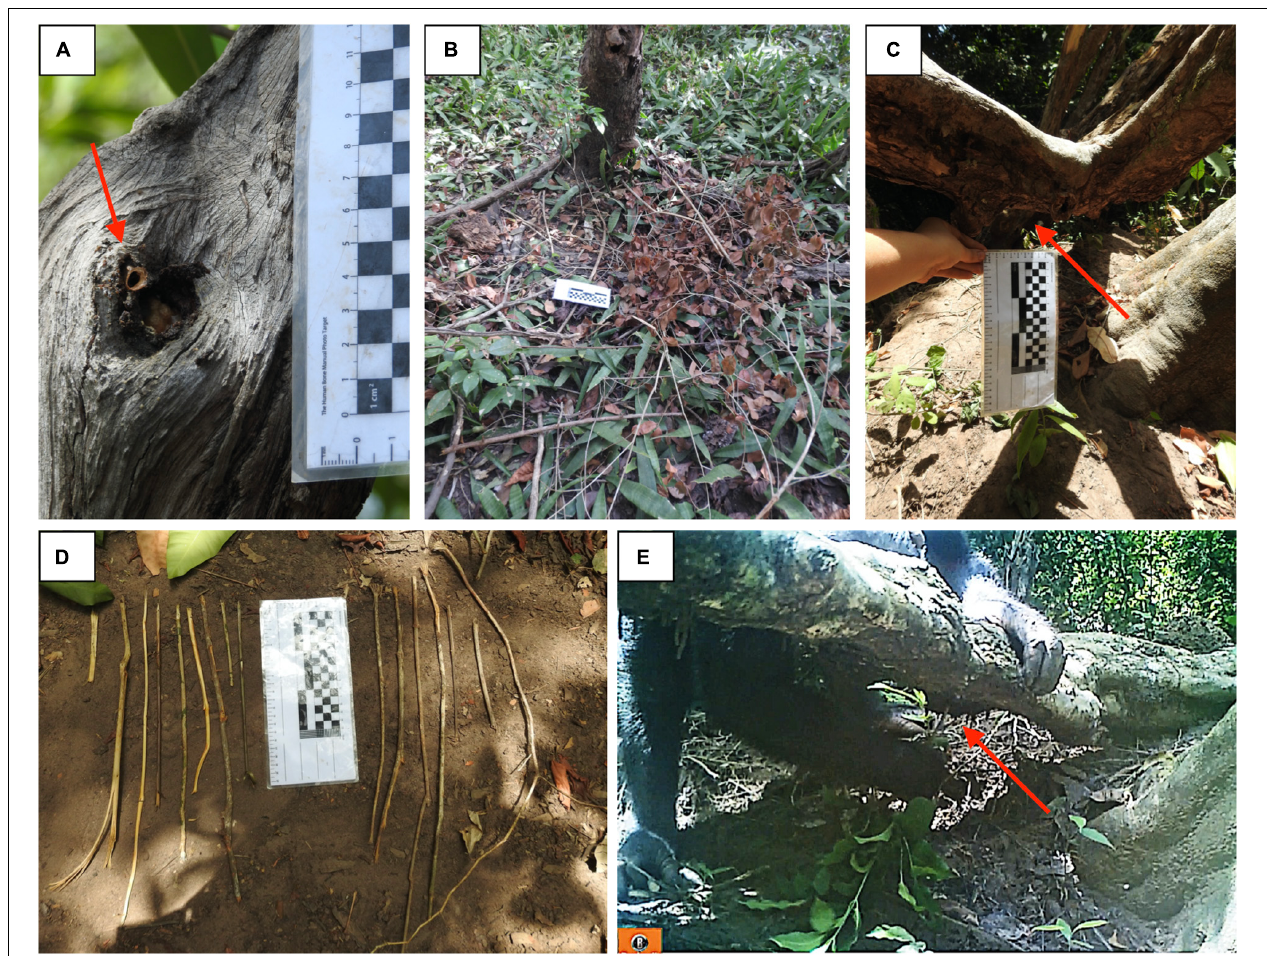
FIGURE 2 | Beehives and tools used to extract honey by chimpanzees in CNP. (A) A small stingless bee (Meliplebeia sp.; MM) hive located in the mangrove area at Madina. The arrow points to the entrance tube of the stingless bees’ hive; the hive’s entrance covered by wax has been exposed, tools were found next to the hive. (B) . A large stingless bee ( Meliponula sp.; BM) hive exploited by chimpanzees in secondary open forest at Cambeque, with tools in situ (C) . A large stingless bee ( Meliponula sp.; BM) hive located in secondary forest at Cambeque. The arrow points to the entrance tube of the stingless bees’ hive; the hive’s entrance covered by wax has been exposed. (D) Tools found by hive (C) with two different estimated ages of use – one-day-old (new) on the left, approx. 1-week-old (recent) on the right. (E) Screenshot from camera trap footage showing a juvenile chimpanzee inserting a manufactured tool into the hive shown in (C) in Cambeque secondary open forest (tool indicated by red arrow) (see Supplementary Material 3 . Observation